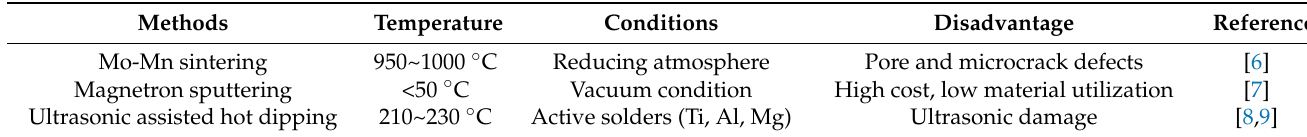
Table 1. Studies on metallization methods on sapphire.